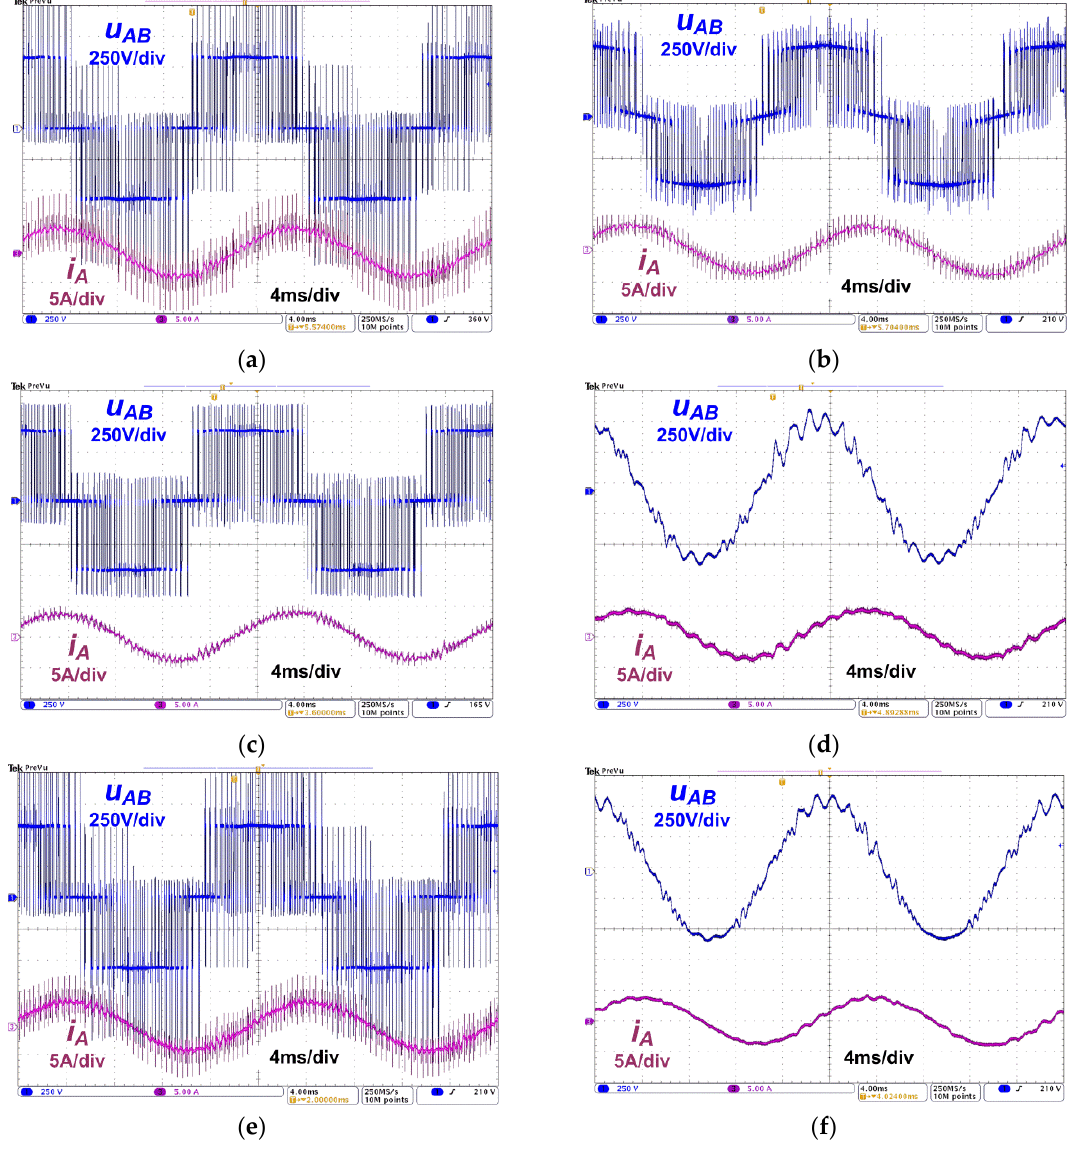
Figure 23. Experimental waveforms of line-to-line voltage u AB and current i A measured at motor terminals in a configuration with a 10 m cable for: ( a ) inverter; ( b ) motor choke; ( c ) du/dt choke; ( d ) sine-wave filter; ( e ) CM choke; ( f ) CM choke with sine-wave filter.